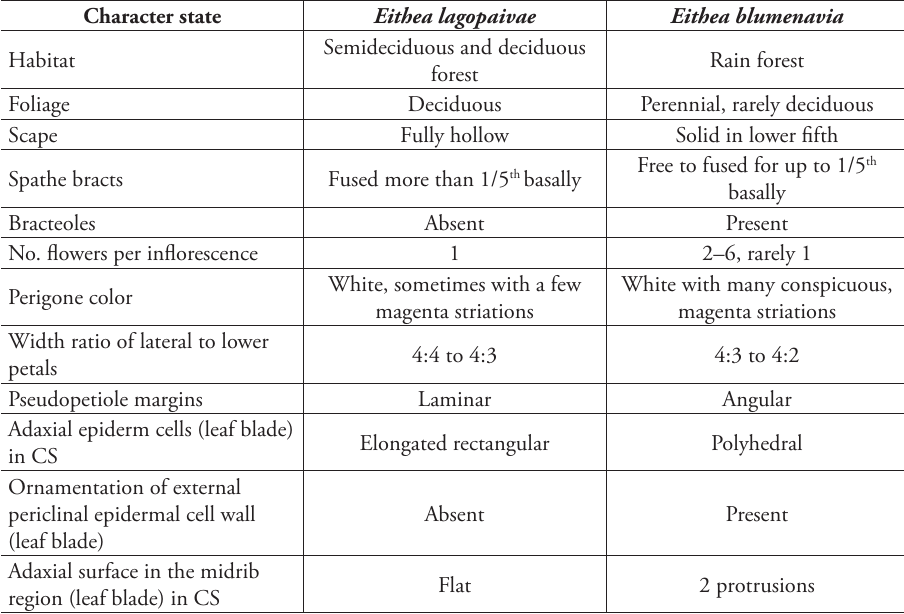
Table 1. Ecological, morphological and anatomic character states that distinguish Eithea lagopaivae from E. blumenavia . CS = cross